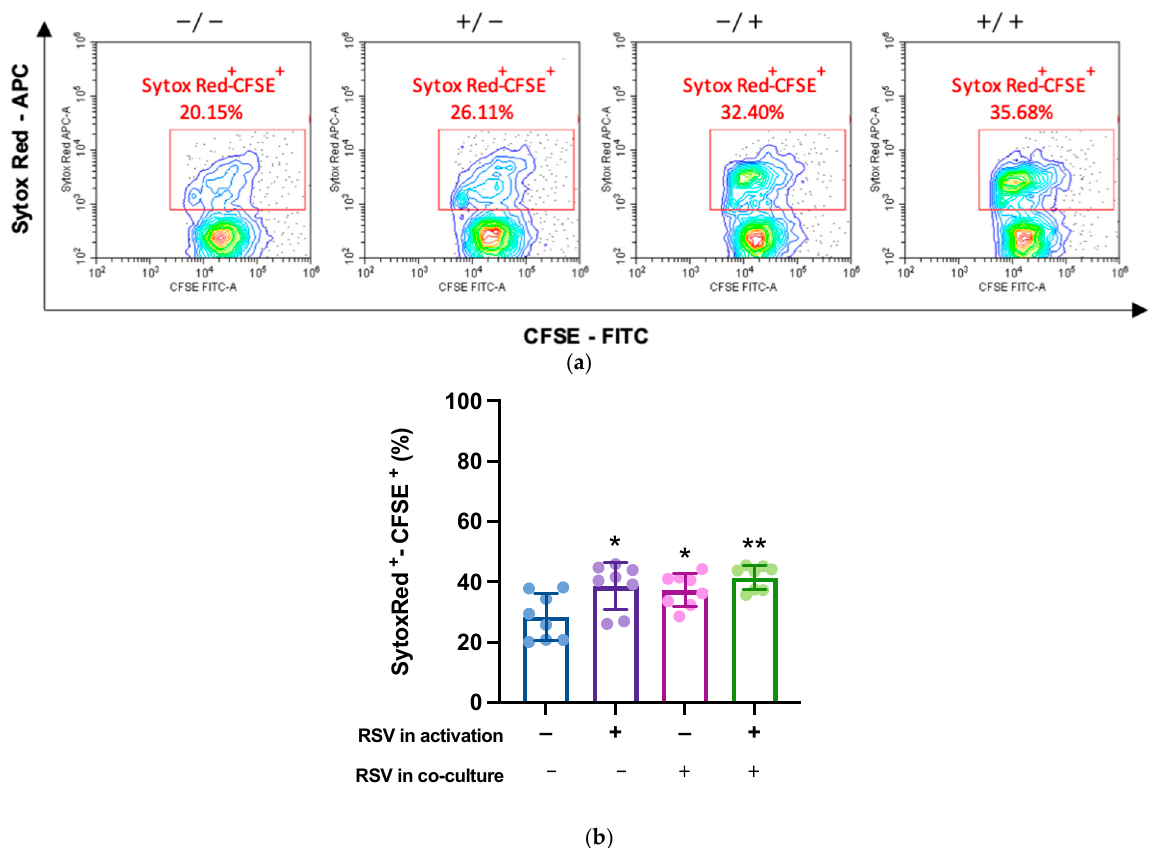
Figure 6. Effects of RSV on the lymphocytic killing activity on target cells. Activated lymphocytes (effector cells) were mixed